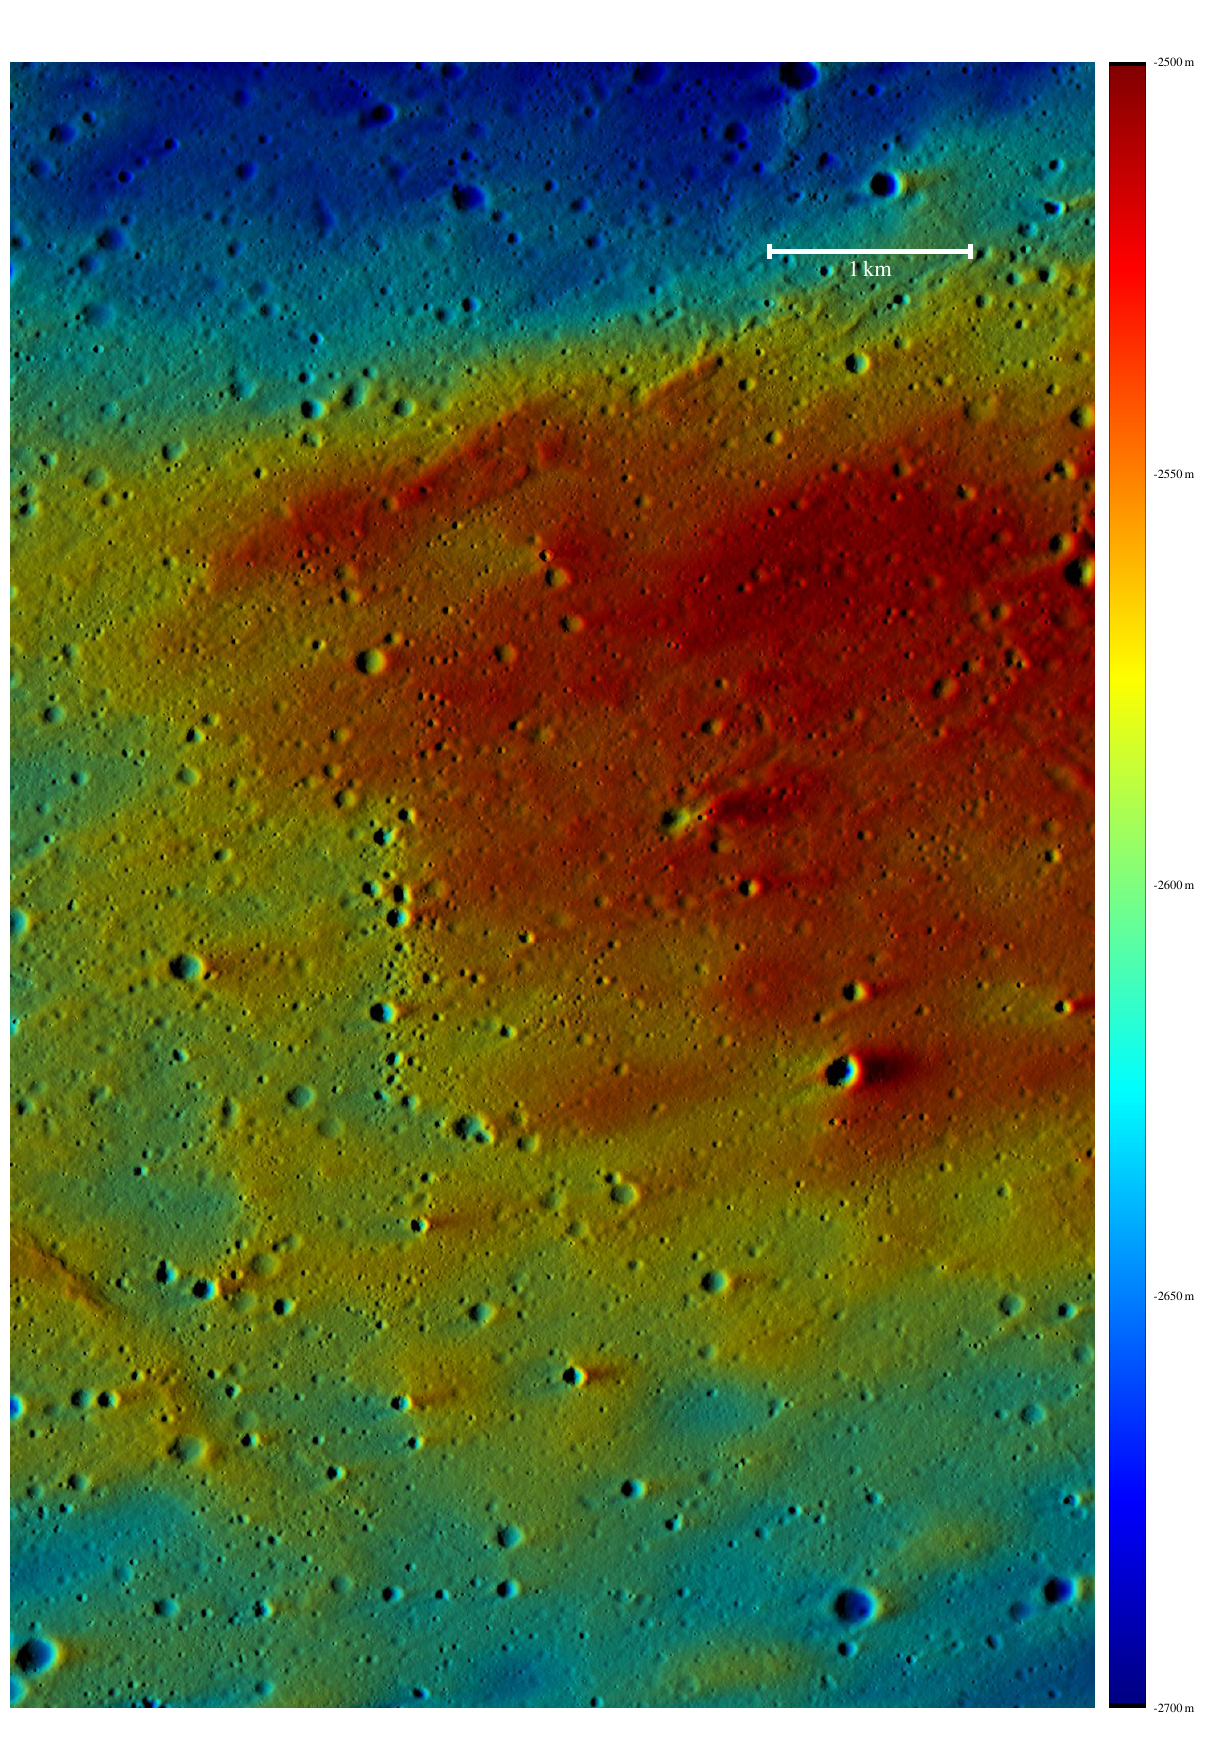
Figure 3: Close-up view of Area